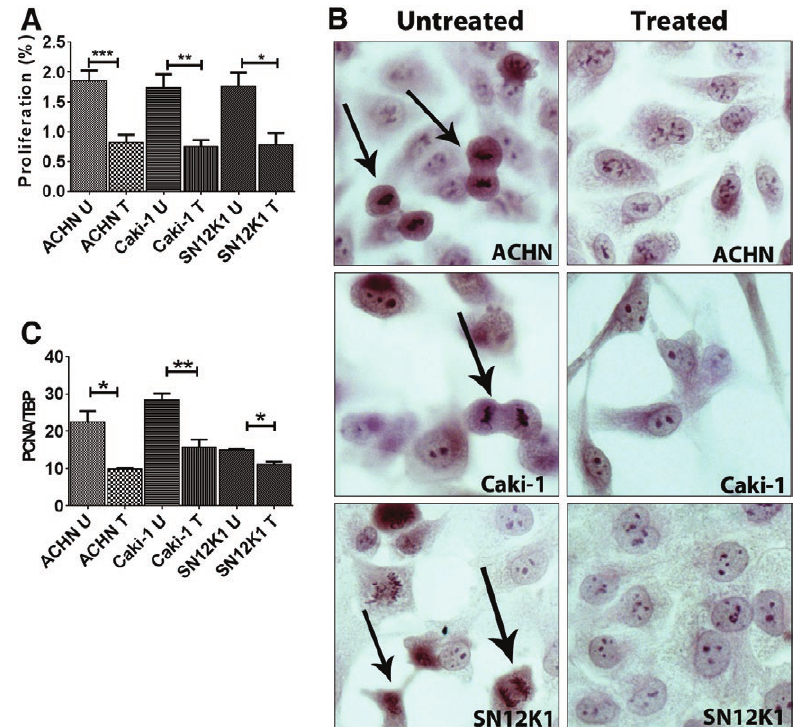
Figure 2. Maslinic acid significantly reduced the proliferation of RCC cells. Twenty-four hours after treatment, maslinic acid induced a significant reduction in proliferation of all three RCC cell lines (A). Representative images of untreated cells and cells treated with maslinic acid are demonstrated in B. Arrows highlight proliferating cells. At the molecular level, maslinic acid significantly reduced the expression of PCNA (C).* P < 0.05; ** P < 0.01, and *** P < 0.001. U: untreated; T: treated with maslinic